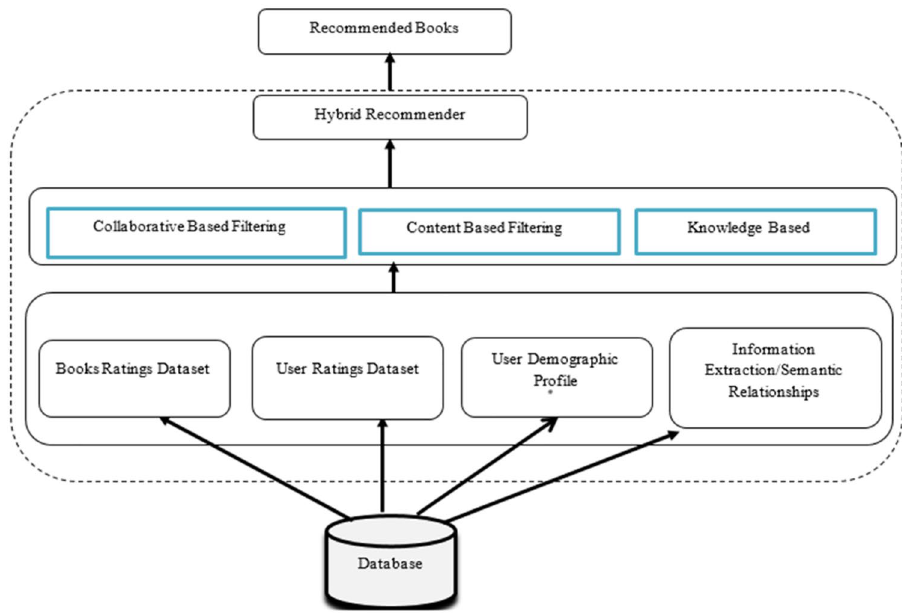
Figure 1. The proposed